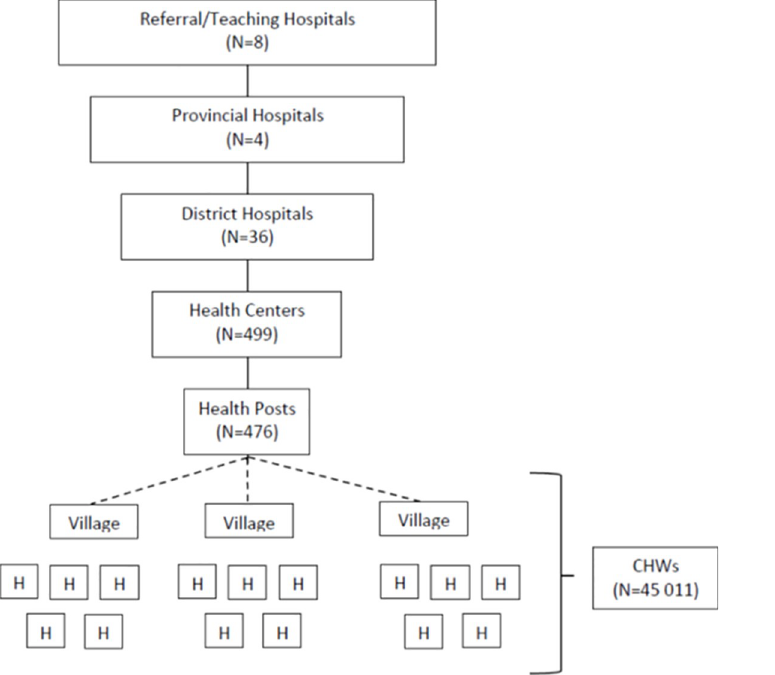
Fig 1. Rwanda health system organizational structure (adapted from